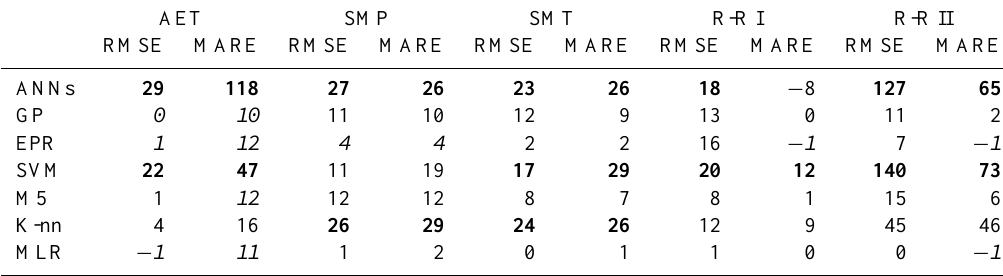
Table 17. The percent deterioration of model performance during testing compared to